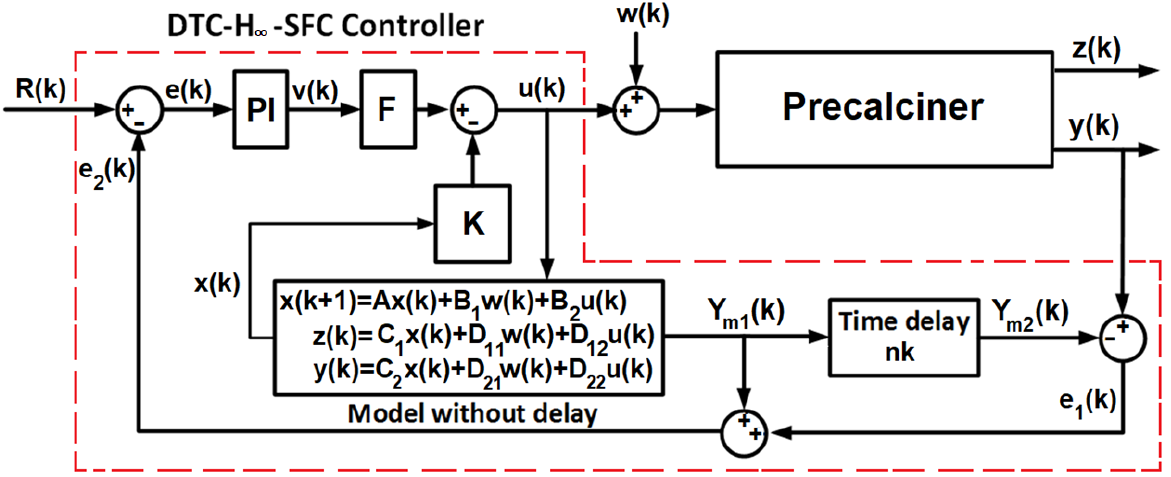
Figure 5. Diagram of the designed precalciner temperature control system with the designed DTC- H ∞ -SFC controller.